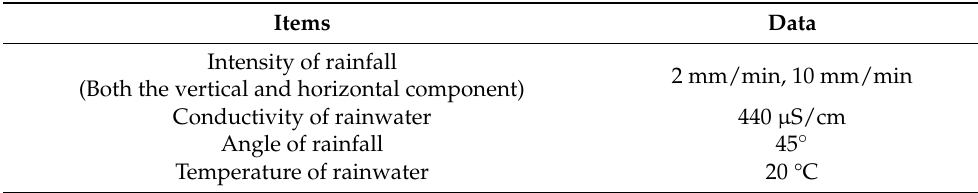
Figure 1. Test setup of the artificial contamination rain flashover test. (1) Test transformer; (2) protective resistor; (3) alternating current voltage divider; (4) direct current supply; (5) protective resistor; (6) direct current voltage divider; (7) leakage current measuring sensor; (8) high voltage bushing; (9) test chamber; (10) specimen; (11) artificial rainfall system; (12) camera; (13) control system. Table 2. Parameters of the artificial rain used in the